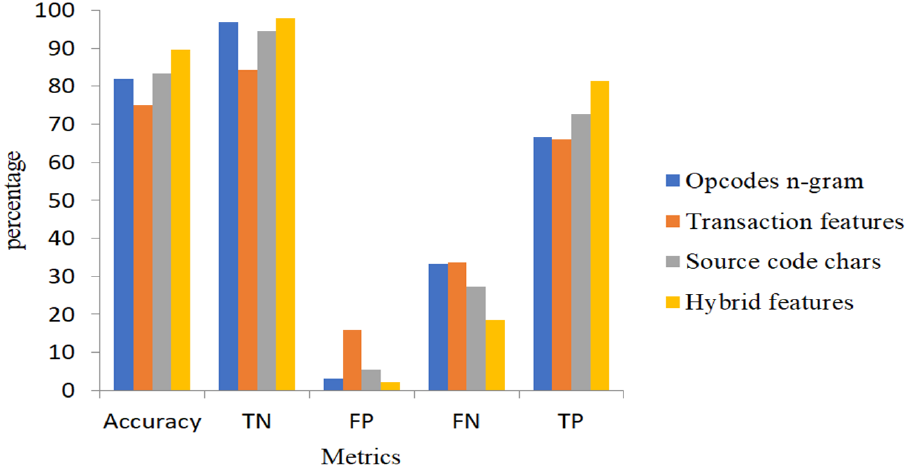
Table 6. Evaluation of the proposed feature set using the ensemble classifier.